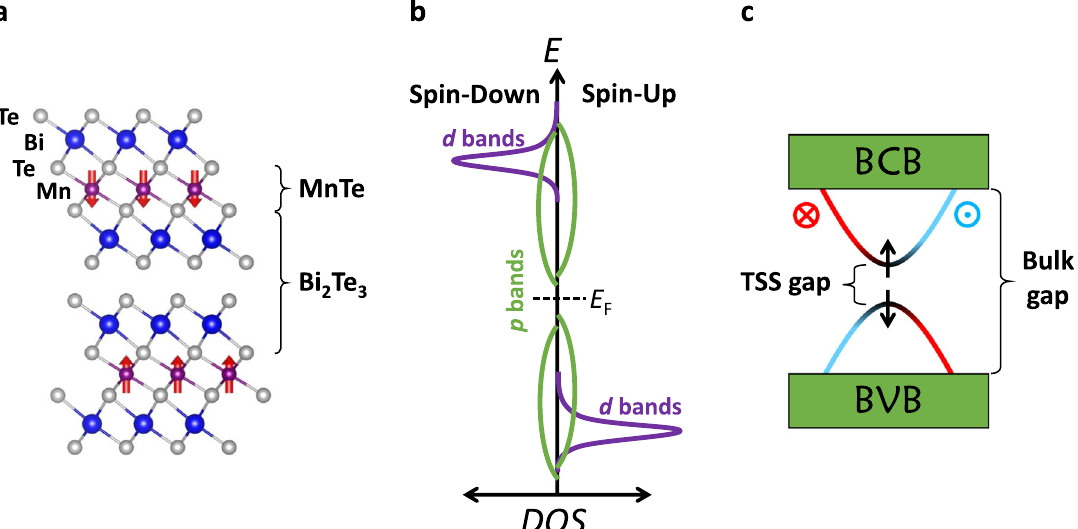
Fig. 1 Lattice and electronic structures of MnBi 2 Te 4 . a Schematic lattice structure of MnBi 2 Te 4 . b Schematic bulk energy band structure of MnBi 2 Te 4 . c Schematic topological surface states (TSSs) of MnBi 2 Te 4